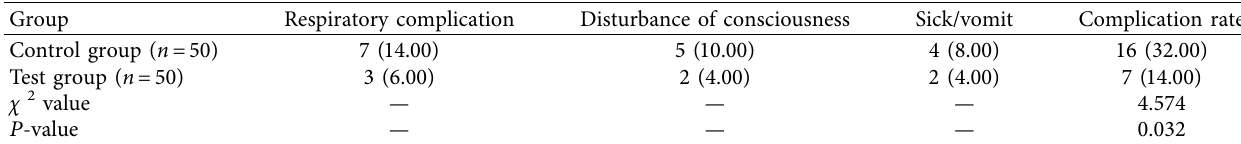
Table 6: Comparison of delirium assessment and complications between the two groups. Group